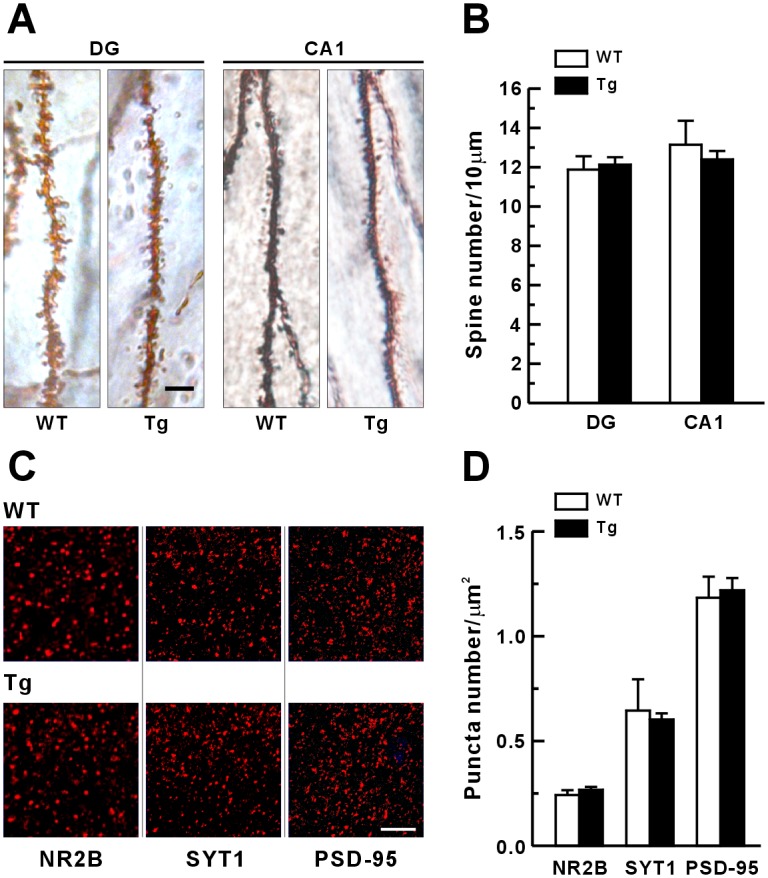
Normal density of dendritic spines and expression of synaptic molecules in IP3K-A Tg mice.(A), Representative images of Golgi-stained dendritic segments of CA1 and DG neurons in WT and Tg mice. Scale bar, 5 μm. (B), Quantification of dendritic spine density. Mean ± SEM. (WT, n = 60 neurons, 5 mice; Tg, n = 45, 4). (C), Representative images of immunohistochemistry of NR2B (C1), synaptotagmin 1 (SYT1; C2), and PSD-95 (C3) at the apical dendritic region of hippocampal CA1 pyramidal cells. Scale bar, 5 μm. (D), Quantification of immunofluorescent puncta of NR2B, SYT1 and PSD-95.